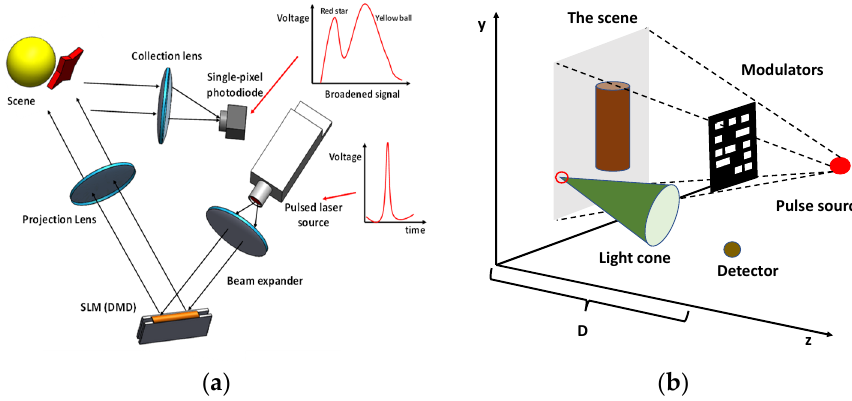
Figure 16. General architecture of ( a ) the time-of-flight approach to construct a 3D imaging with a pulsed laser source and high timing resolution detector [150] and ( b ) the lensless imaging system [157].